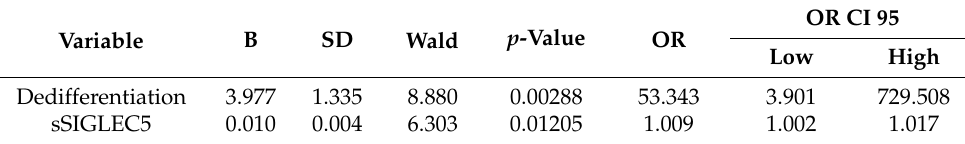
Table 2. Logistic regression model for exitus prediction in colorectal